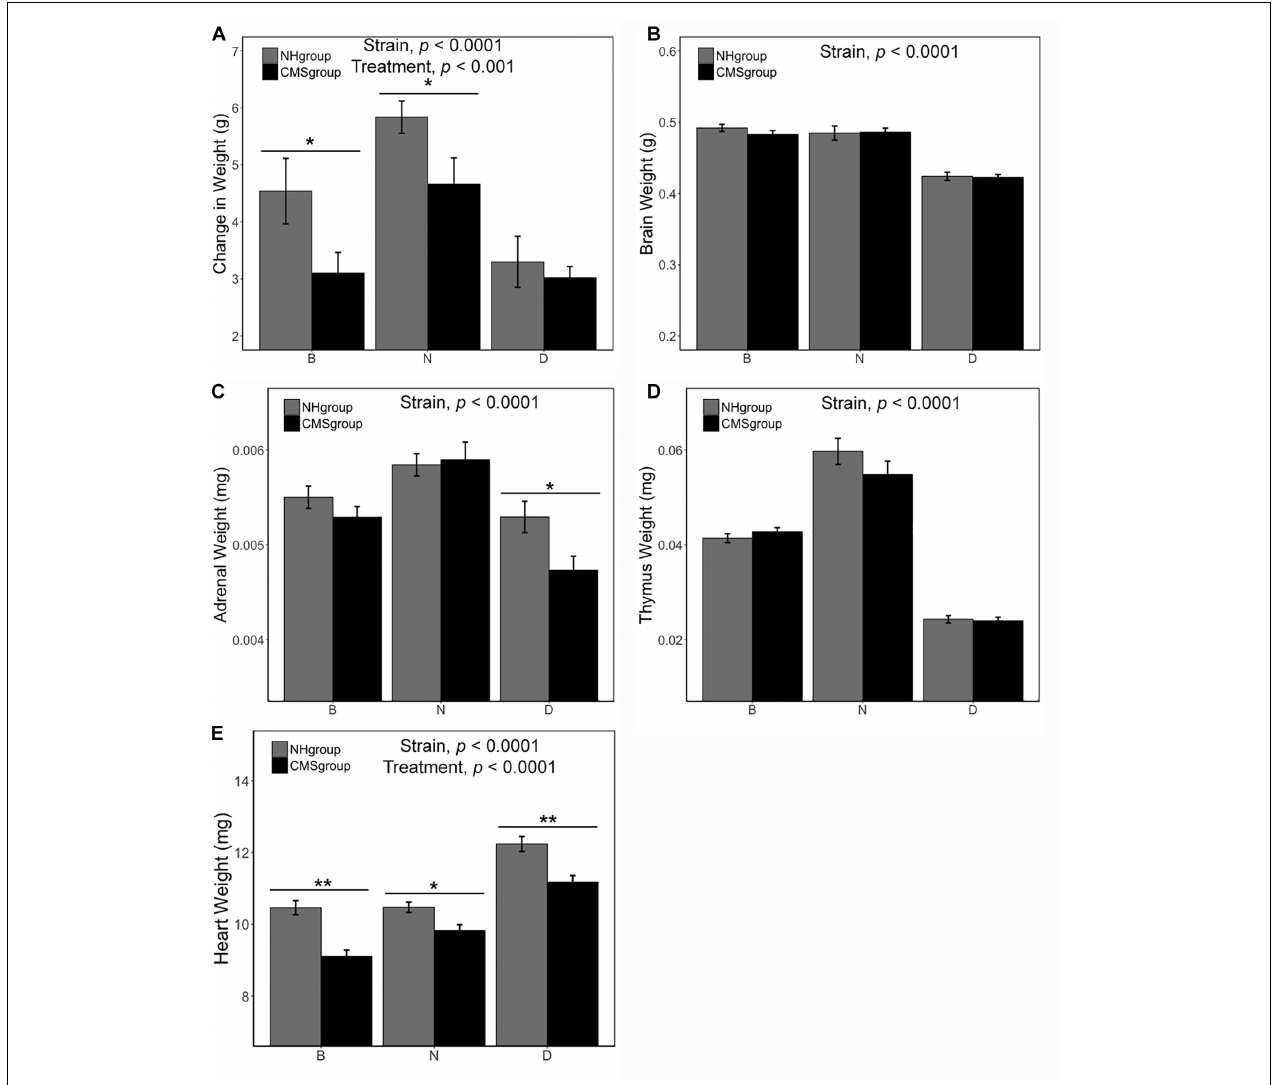
FIGURE 2 | Body and organ weight measures following CMS treatment. Subjects in the CMS and CMS-R groups were pooled (CMSgroup; black) and subjects in the NH-R and NH groups (NHgroup; gray) were pooled for the analysis because there was no effect of restraint on body or organ weight. Difference in body weight between the end and beginning of chronic stress is significant for the B and N substrains with both strains showing less weight gain in the CMS group (A) . Following 7 weeks of CMS, tissue was harvested and weighed for all strains. Brain weight (B) was not altered by treatment but was significantly different between the D strain and both B and N substrains [D < B, t (49.25) = 12.32, p = 2.2e-12 and D < N, t (35) = 10.17, p = 5.46e-12]. Adrenal weight (C) was dependent on strain. The N strain had the largest adrenals [N > B, t (50.49) = 3.46, p = 0.001 and N > D, t (56.94) = 5.42, p = 1.27e-06] and the D strain had the smallest [D <